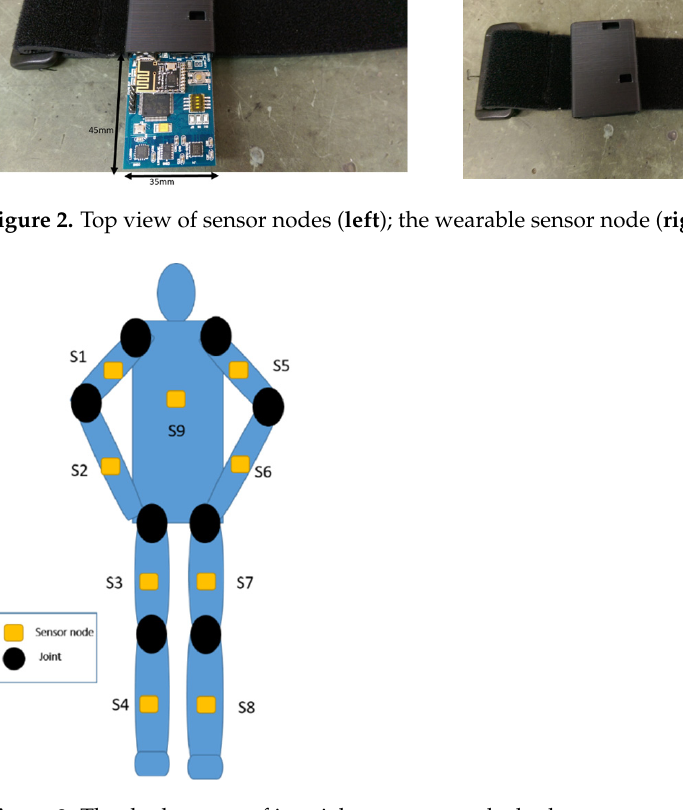
Figure 3. The deployment of inertial sensors over the body.